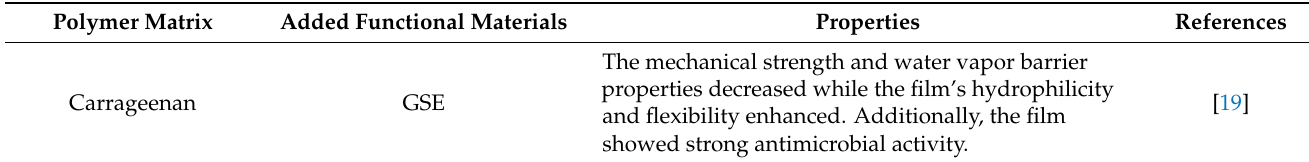
Figure 3. ( A ) Schematic representation of polyvinyl alcohol-based functional composite film added with GSE and curcumin (Reproduced from Roy & Rhim, 2021 [25]); ( B ) Schematic drawing of gelatin-based film incorporated with GSE and TiO 2 (Reproduced from Riahi et al., 2021 [51]); ( C ) Schematic diagram of polylactic acid (PLA)/poly(butylene-adipate-co-terephthalate) (PBAT)-based composite films mixed with GSE (Reproduced from Shankar & Rhim, 2018 [28]). Table 1. Overview of the GSE application in the food packaging films.